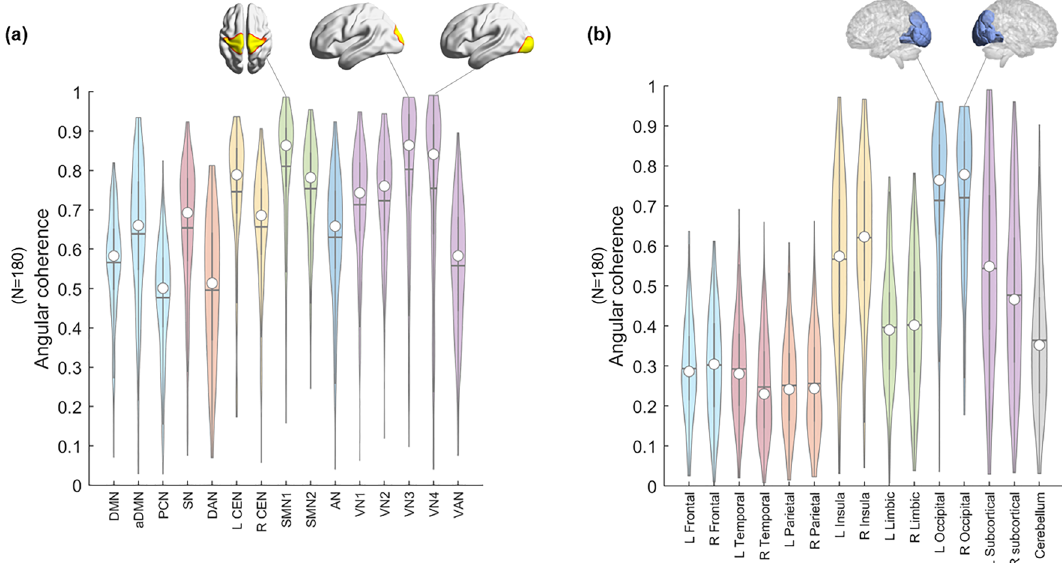
Figure 2. Distribution of the angular coherences of 180 individuals’ voxels on hyperbolically embedded discs. Groups of voxels belonged to ( a ) functional labels derived from group independent component analysis (ICA) and ( b ) atlas-based anatomical labels. ( a ) Fifteen independent components were chosen from group ICA for the entire data: default mode network (DMN), anterior DMN (aDMN), precuneus network (PCN), salience network (SN), dorsal attention network (DAN), left central executive network (L CEN), right CEN (R CEN), sensorimotor network (SMN) 1/2, auditory network (AN), visual network (VN) 1/2/3/4, and visual attention network (VAN). The spatial maps of ICs were binarized (Z > 6), and voxels were classified to belong to each of the specific ICs. The coordinates of groups of voxels per specific IC were calculated (see “Methods” section). The values of angular coherence of SMN and VN3 and VN4 were the highest. ( b ) The whole brain was segmented into fifteen anatomical lobes based on the Brainnetome atlas to yield anatomical labels: bilateral frontal/ temporal/parietal/limbic/occipital/subcortical and a cerebellum. The coordinates of groups of voxels per lobe were calculated (see “Methods” section). The median of each distribution is indicated with a circle, and the mean is indicated with a horizontal